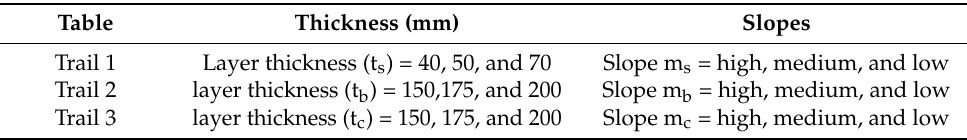
Figure 6. Experiment setup in controlled experiments. Table 1. Considered variable values for data